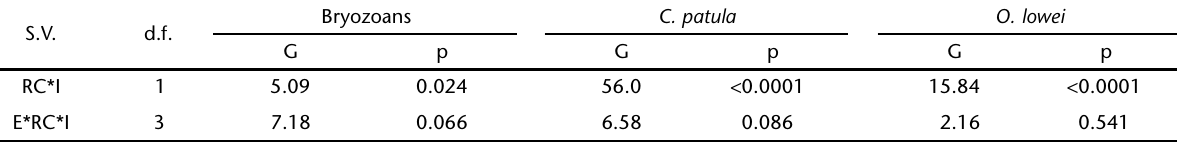
Table III. Arenaeus cribrarius . Significance of the Source of Variation (S.V.) of the log-linear models for the prevalence of infestation (I; present or absent) from the adult females collected in Ubatuba (São Paulo), from May/1991 to April/1993. (E) Season: spring, summer, fall, winter; (RC) reproductive condition: non-ovigerous females and ovigerous